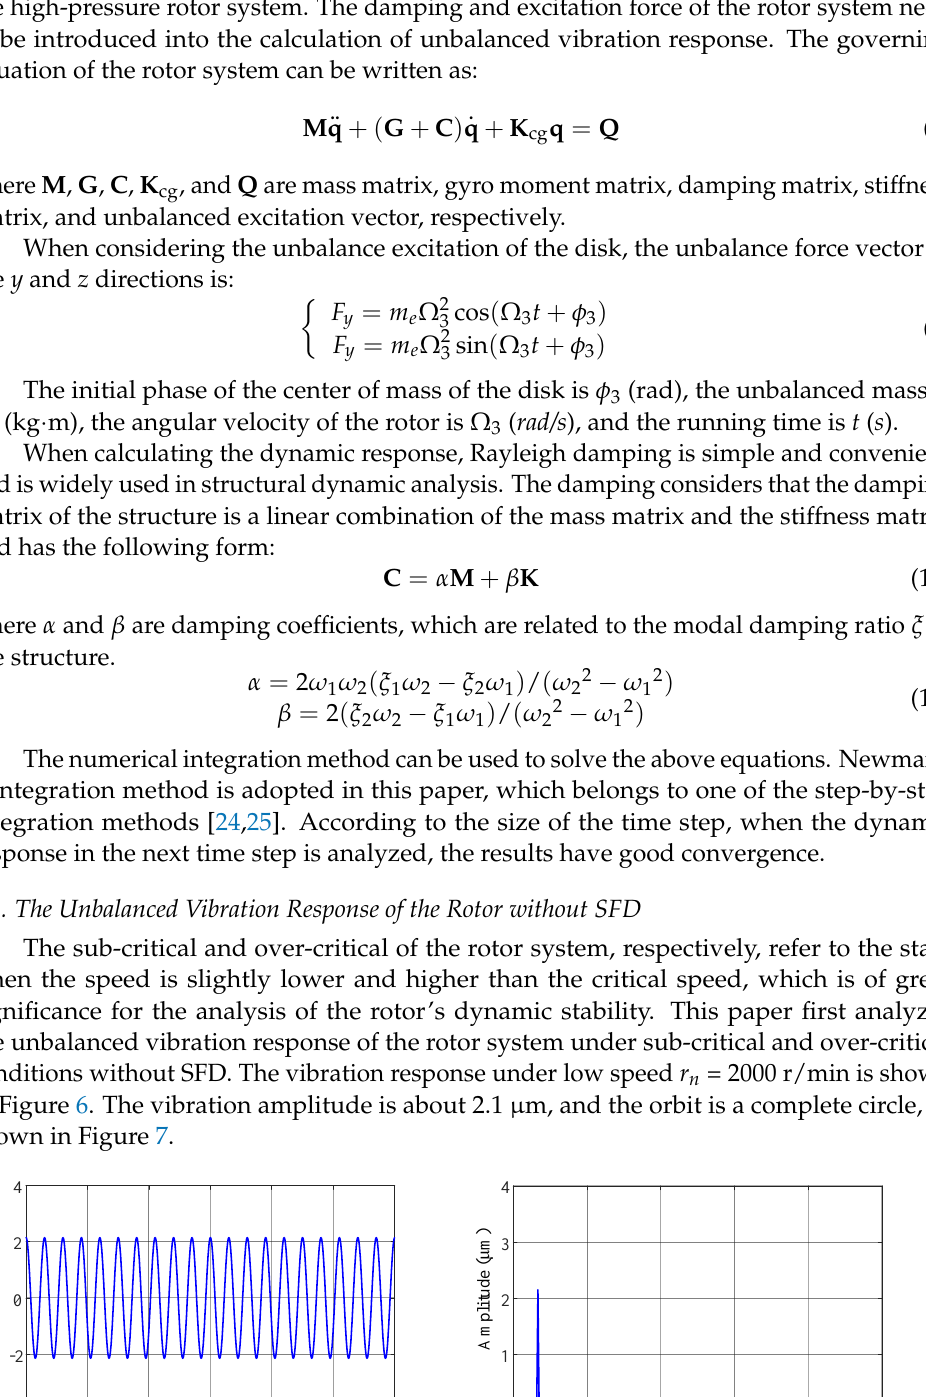
Figure 7. Orbits of high-pressure rotor at low speed. In the case of high speed r n = 12,800 r/min, the vibration response is shown in Figure 8. The amplitude is about 3 μm, and the orbit is a complete circle, as shown in Figure 9. It can be found that the vibration response amplitude of the rotor system without SFD is very small (less than 5 μm ) at different speeds, and the orbits are complete circles. 0 ( b ) Figure 8. Response of high-pressure rotor at high speed. ( a ) time domain response; ( b ) frequency domain response.